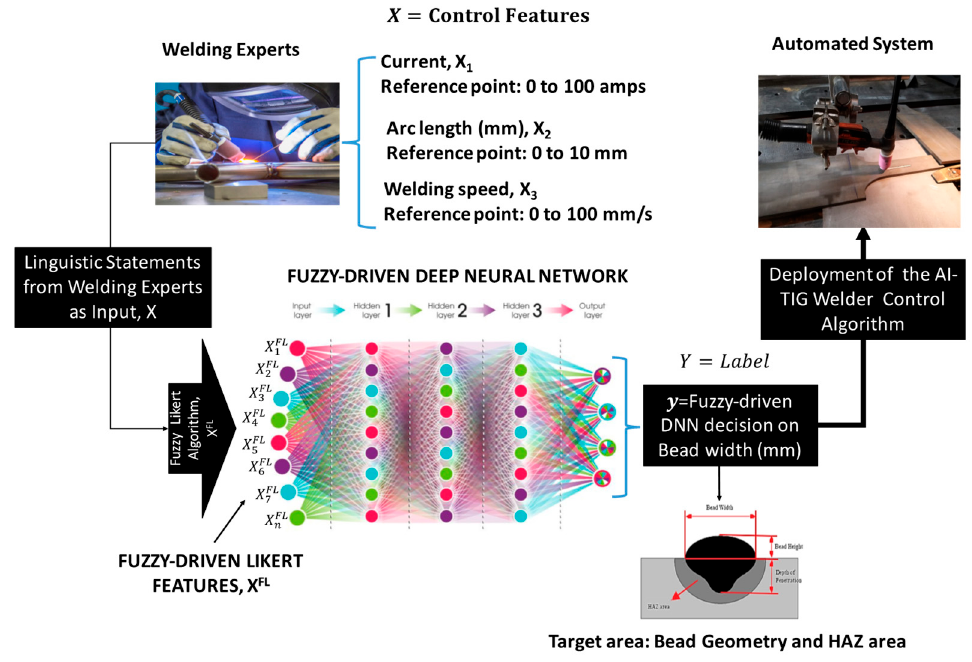
Figure 5. Process model of the artificial intelligence (AI) TIG Welding algorithm modeling steps.